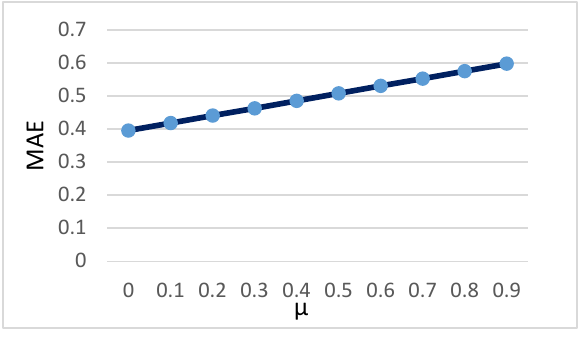
Figure 1. Impact of μ.